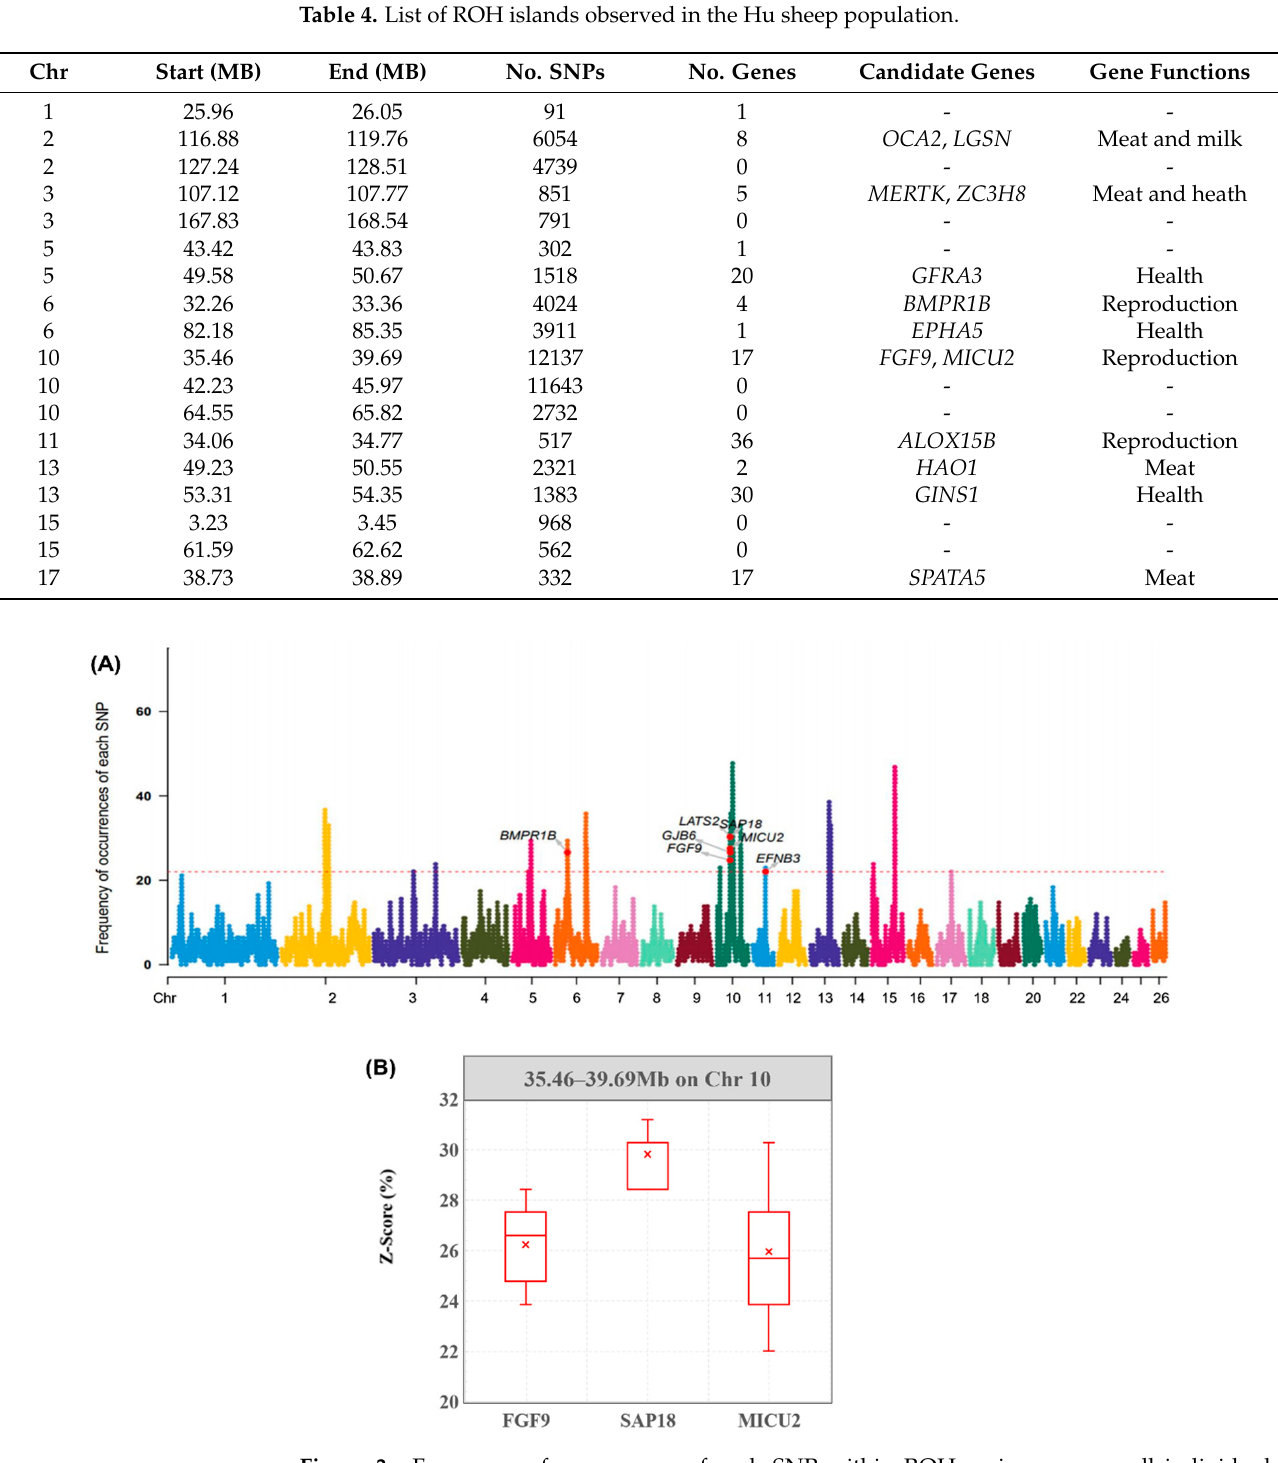
Figure 3. Frequency of occurrences of each SNP within ROH regions among all individuals. ( A ) Horizontal red line represents the 20% threshold. Genes related to reproduction quality hare identified. ( B ) The plot represents the frequency distribution of SNPs within unique gene regions of Hu sheep. The X -axis represents three different candidate genes within the ROH island. The Y -axis represents the frequency of occurrences of each SNP within the gene annotation interval.